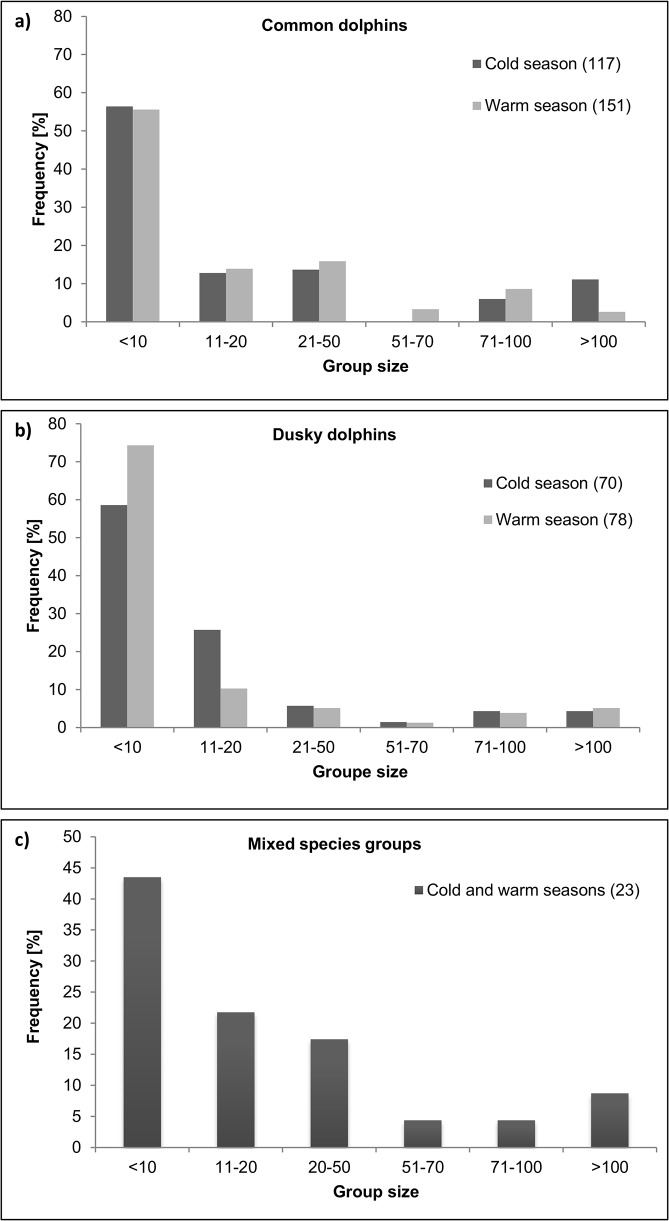
Group size distributions.Frequency distributions (percentages) of group size categories for (a) common dolphins (Delphinus delphis), (b) dusky dolphins (Lagenorhynchus obscurus) and (c) mixed-species groups of common and dusky dolphins. The number in parentheses indicates the sample size.